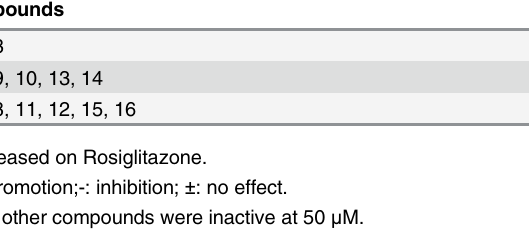
Table 2. Effects of Compounds on Transcription Activity of Increased PPAR- γ . a